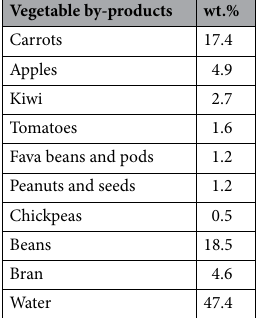
Table 1. Vegetable substrate composition for BSFL growth (wt.%).